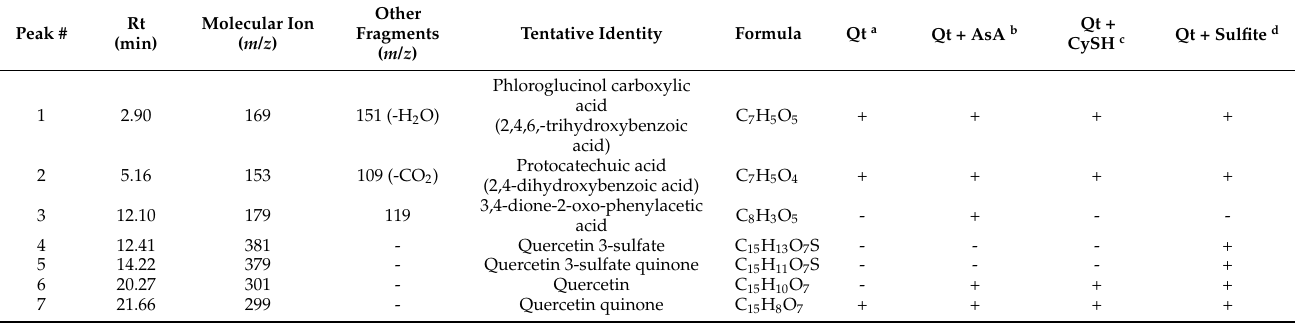
Table 2. Mass spectral data of the major Qt degradation products, detected in Qt solutions after treatment for 50 min, at 90 °C.